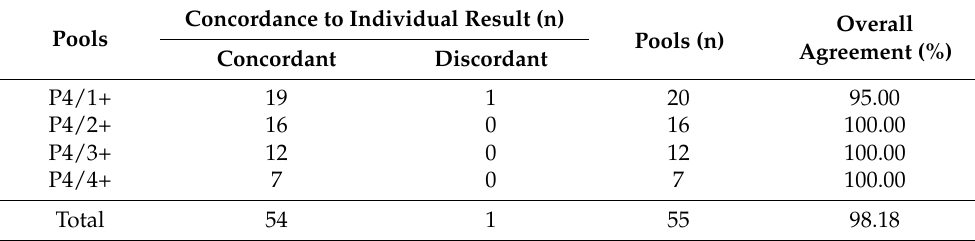
Table 2. Pooling-of-four method in different